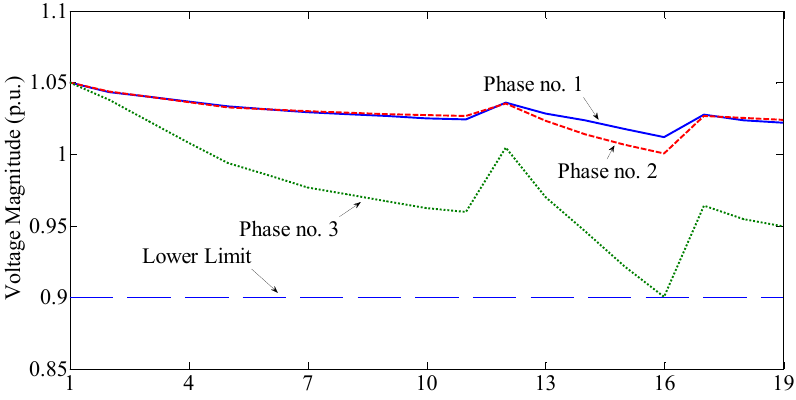
Figure 9. Case Study 2: Voltage magnitude of the residential feeder at hour 21.00 of the last typical day.